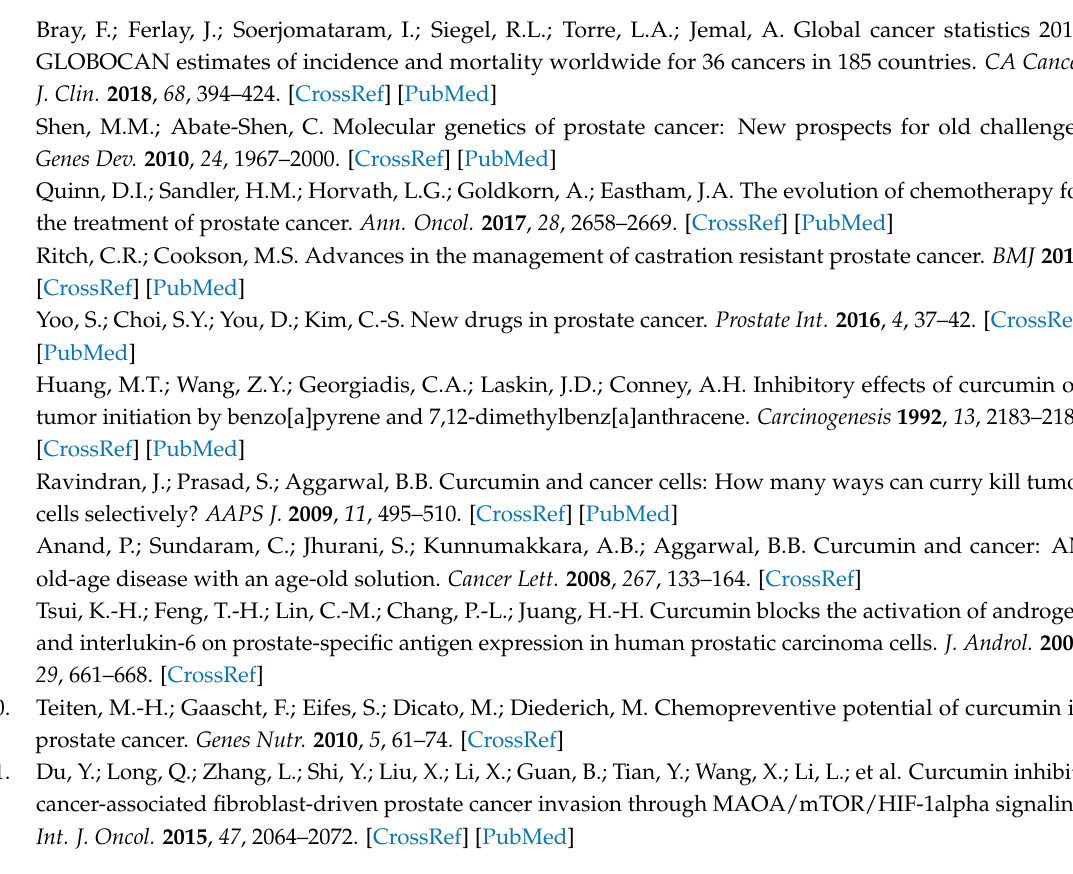
on pH variation, Figure S2: Species distribution curves for ligands in the 3–9 pH range at [L]tot = 2 × 10 − 4 M, Figure S3: Biological activity of K3-derivatives on human colorectal HCT116 cancer cells, Figure S4: Cell cycle analysis of PC3 and DU145 cells, Figure S5: Protein expression analysis of PCa cells following DTX administration. Figure S6: AIG colony assay in PCa